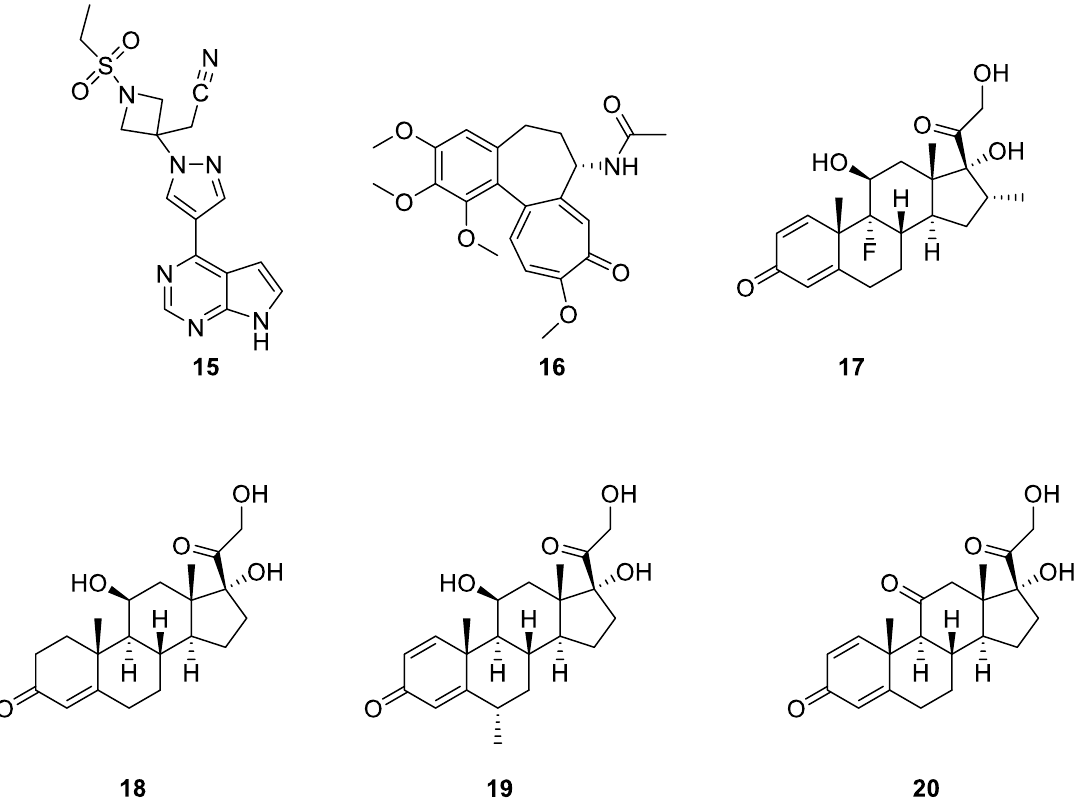
Figure 6. Chemical structure of baricitinib ( 15 ), colchicine ( 16 ), dexamethasone ( 17 ), hydrocortisone ( 18 ), methylprednisone ( 19 ), and prednisone ( 20 ).